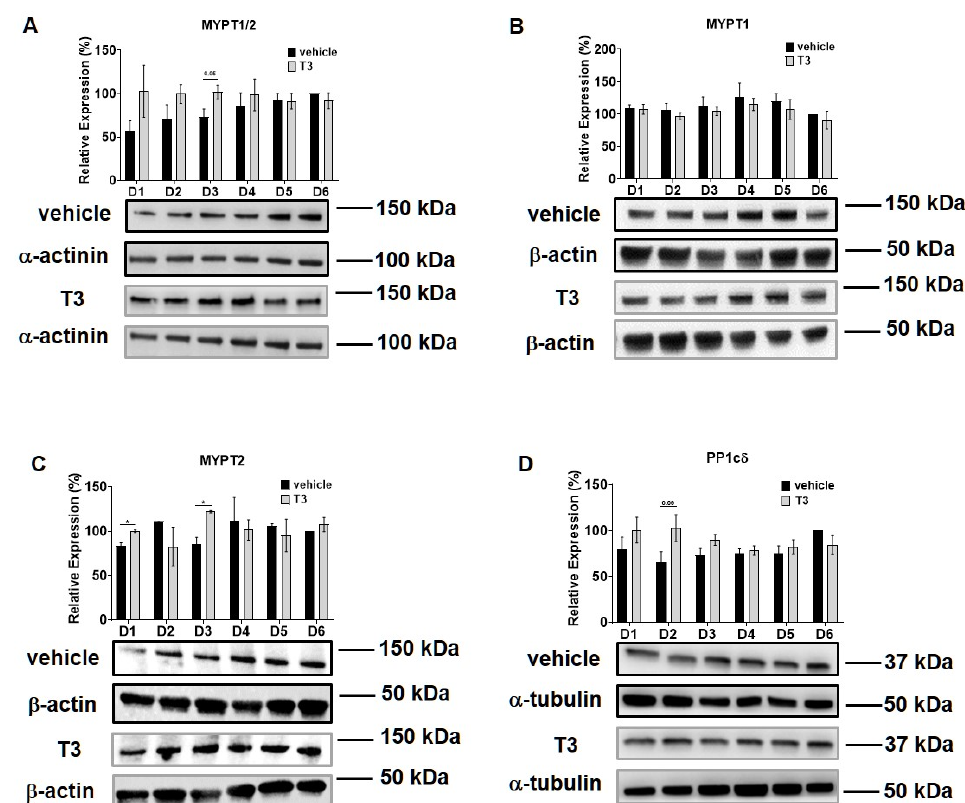
Figure 3. MYPT1/2 and PP1c δ expression during C2C12 myogenesis in the presence of T 3 . Myoblasts were differentiated for 6 days in the presence of 10 nM T 3 or equal amounts of HCl:EtOH solution. Proteins from whole-cell lysates were analyzed using Western blot with anti-MYPT 1 − 296 ( A ), anti- MYPT 1 − 38 ( B ), anti-MYPT2 ( C ) and anti-PP1c δ ( D ) antibodies. Values represent n = 4, mean ± SEM. Data were normalized to the Day 6 vehicle control. Differences between group means were determined using Two-way ANOVA followed by Sidak post hoc test and by multiple unpaired two-tailed t -tests, p < 0.05 (*).